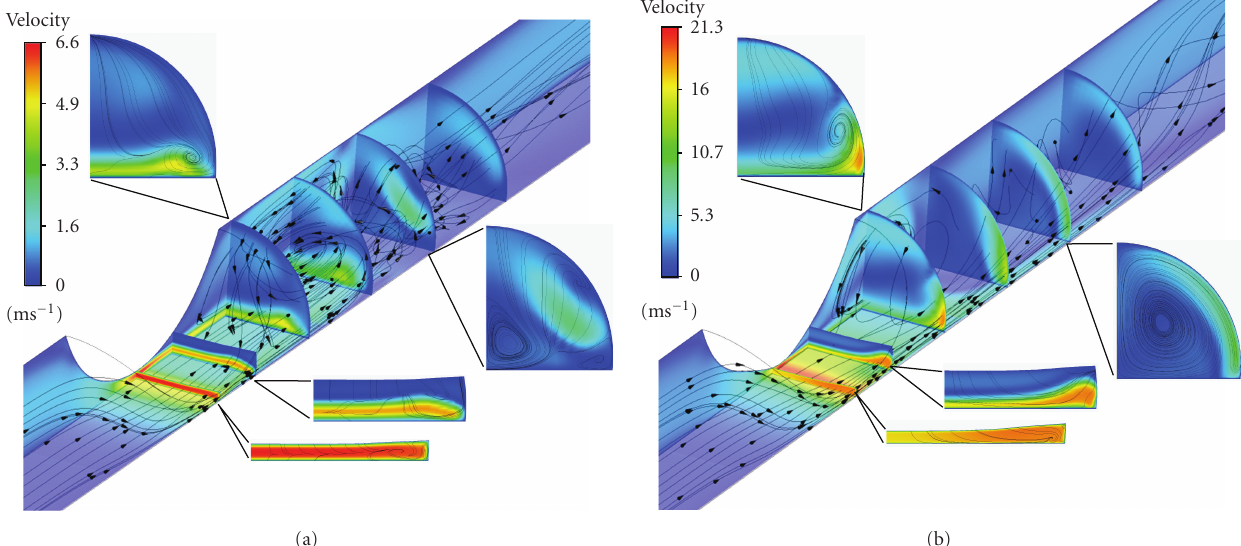
Figure 9: Streamline plot and contours of velocity along vertical symmetry plane, bottom wall and several axial cross-sections for (a) Δ P = 20Pa and (b) Δ P = 200Pa ( h o = 1 . 2mm case).